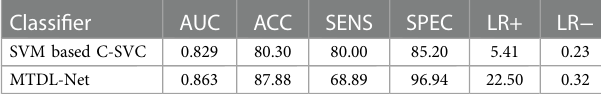
TABLE 5 The corresponding quantitative indexes for WMI status prediction based on different classi fi ers in the testing